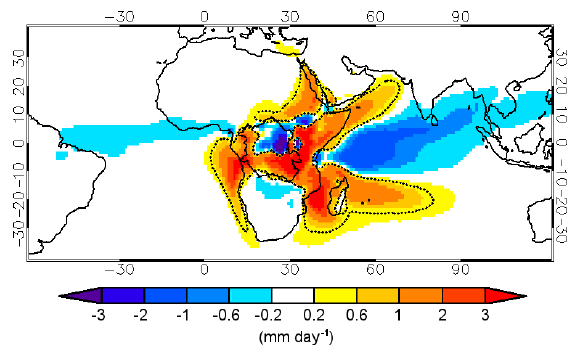
Figure 5. Annual mean ( E − P ) i 10 values backward-integrated over 10 days for the period 1980–2010. The dashed lines repre- sent the boundaries of the moisture sources, which are defined as p 90 = 0.4mmday − 1 .